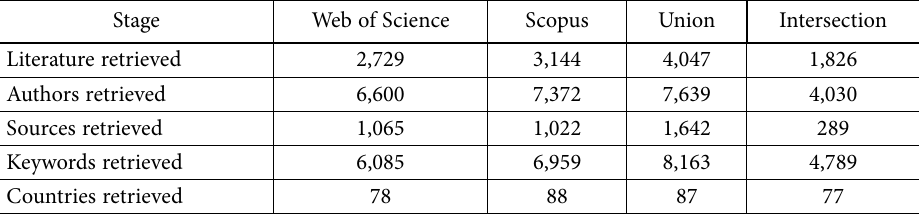
Table 1. Results of the literature search strategy (source: own study based on Scopus and Web of Science data)